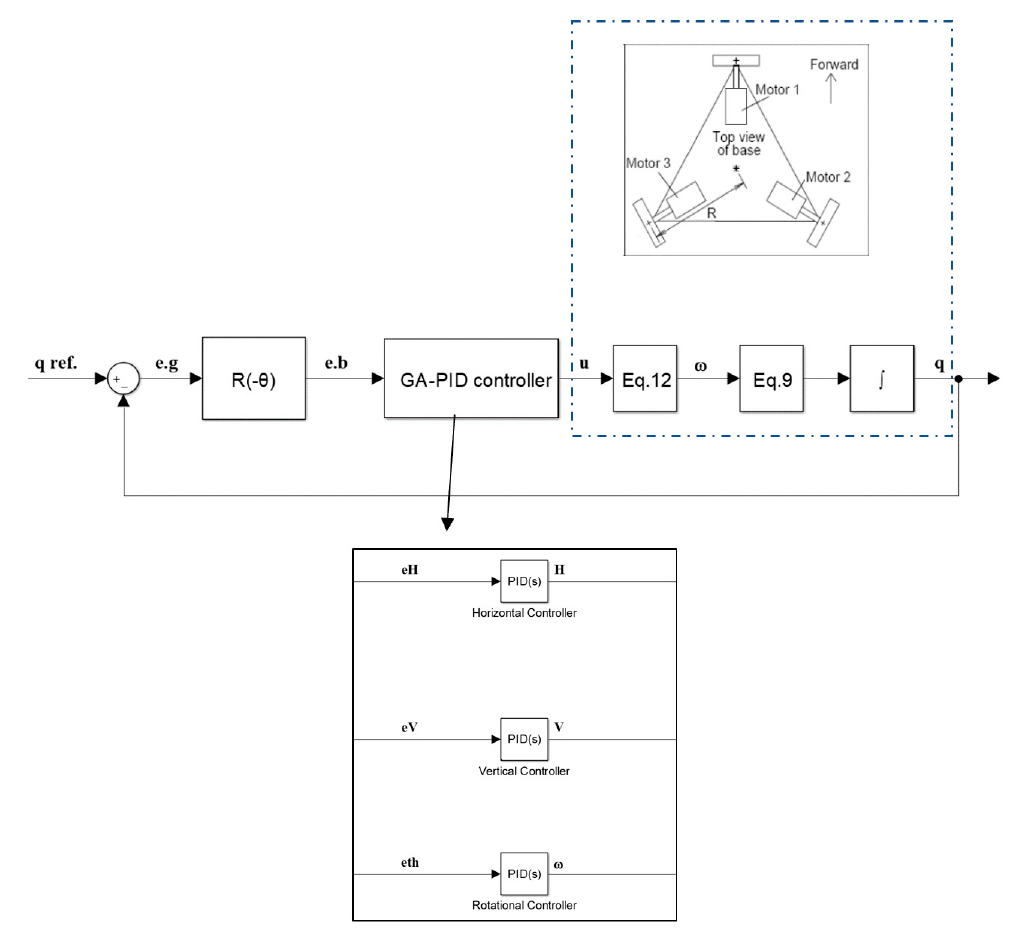
Figure 7. GA-PID controller based on decentralize algorithm.